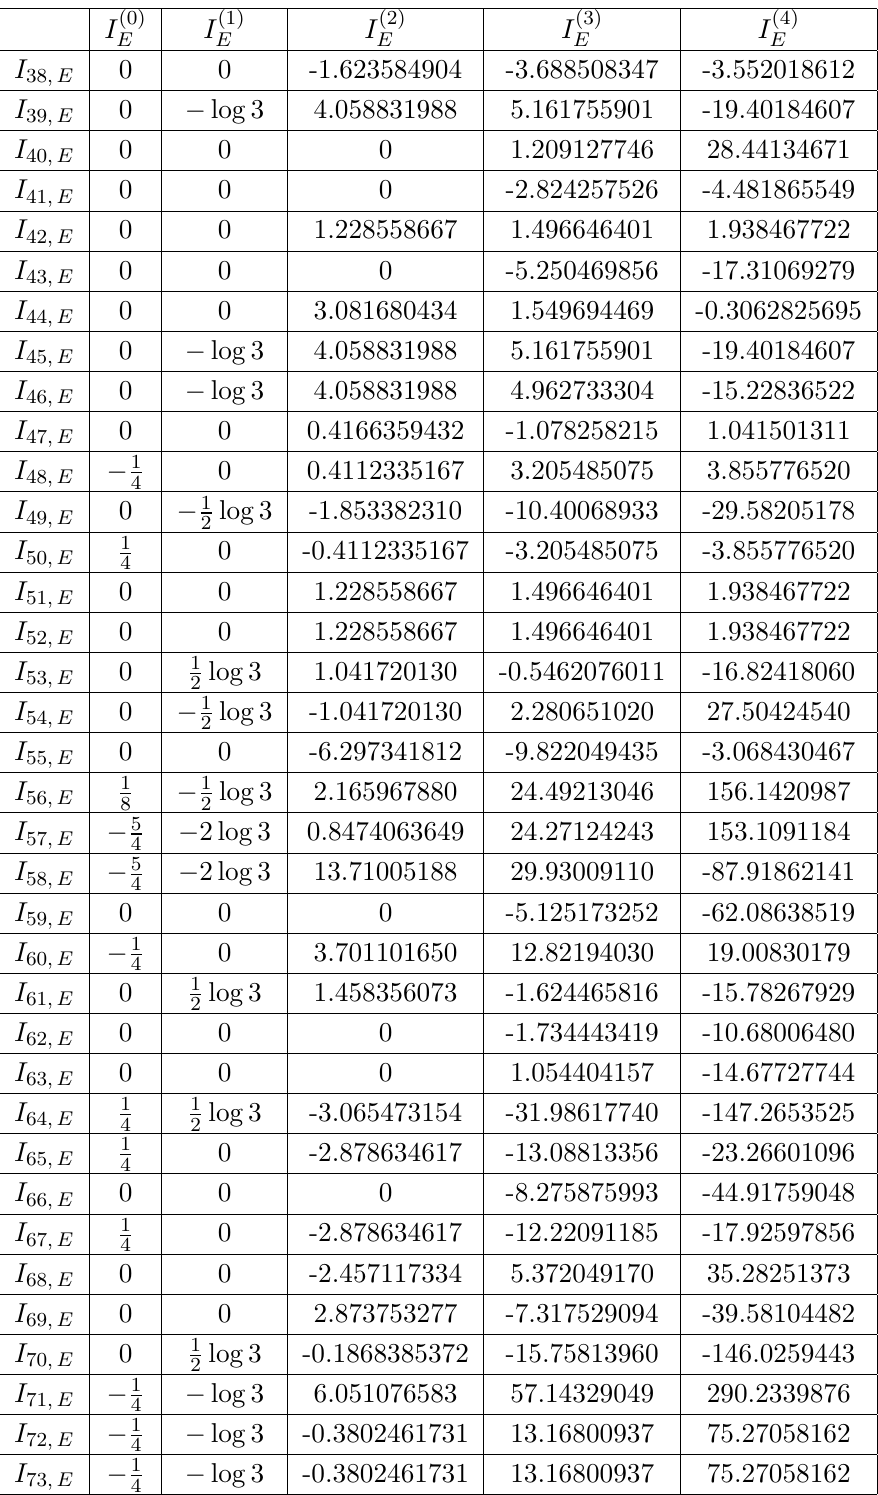
Table 2 . Numerical expressions for the boundary values (integrals from 38 to